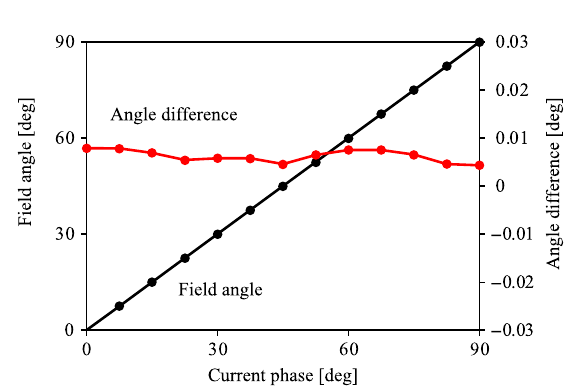
FIG. 6. Magnetic field angle with respect to θ